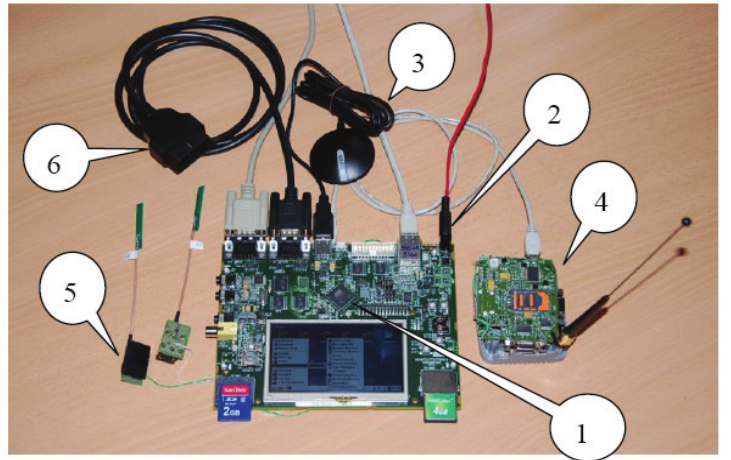
Figure 2. Development